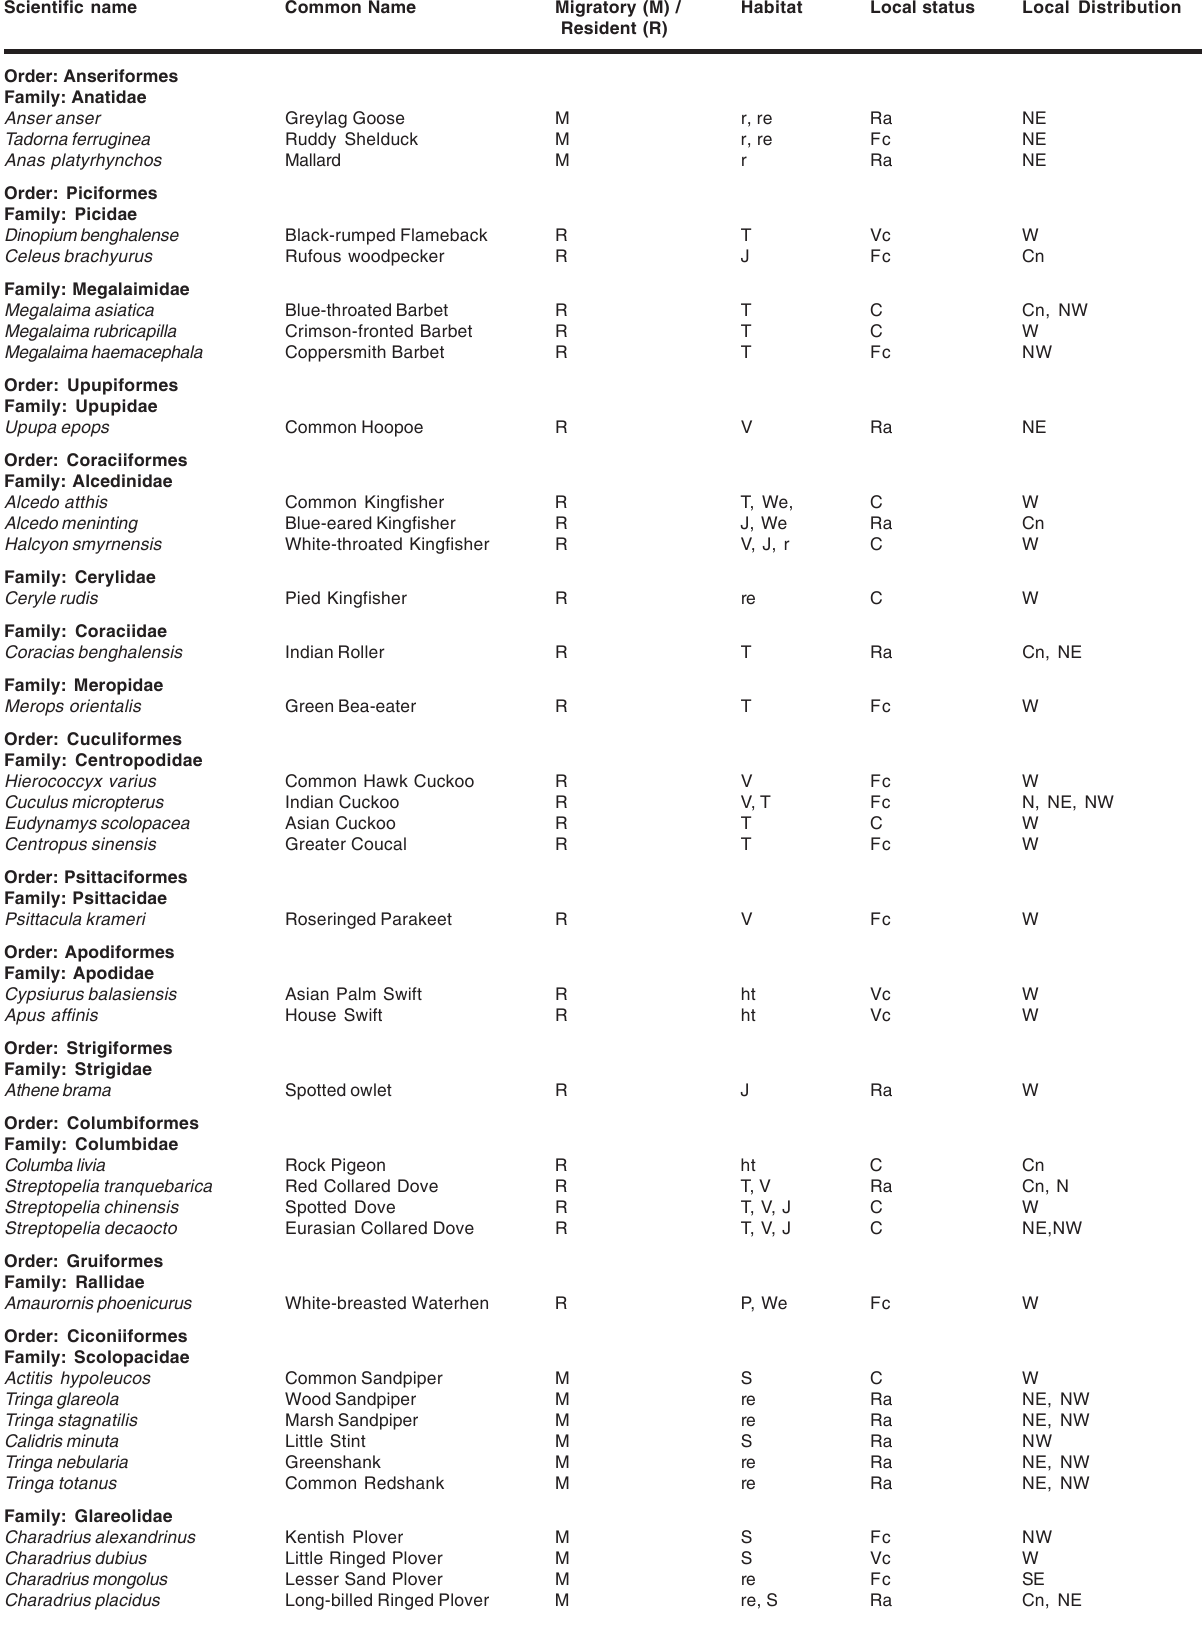
Table 1. Systematic list of the bird species recorded along the Dharala and Brahmaputra rivers in Kurigram District, Bangladesh from November 2000 to February